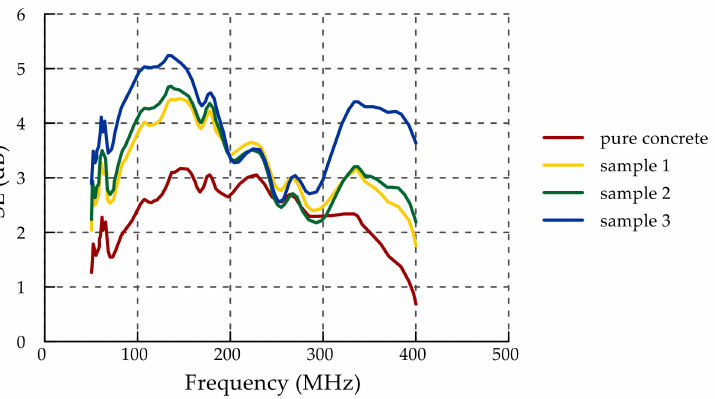
Figure 7. Shielding effectiveness versus wave frequency for the elements tested (after